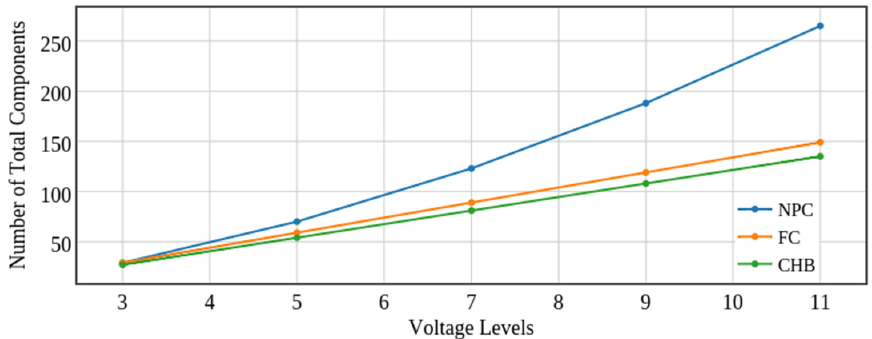
Figure 4. Number of total used components of multilevel inverters for different levels.